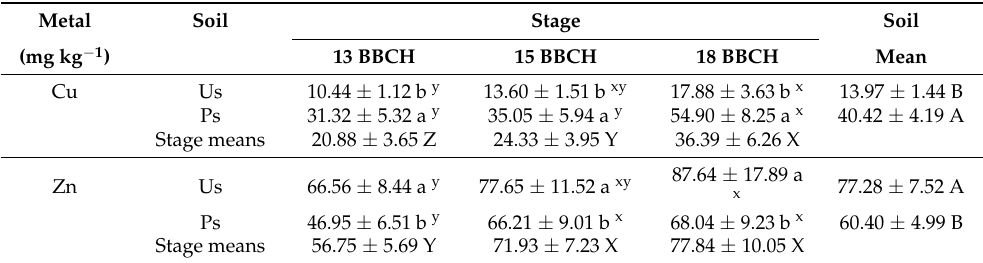
Table 2. Cu and Zn concentrations in different development stages of S. perfoliatum plants grown in heavy metal Ps and